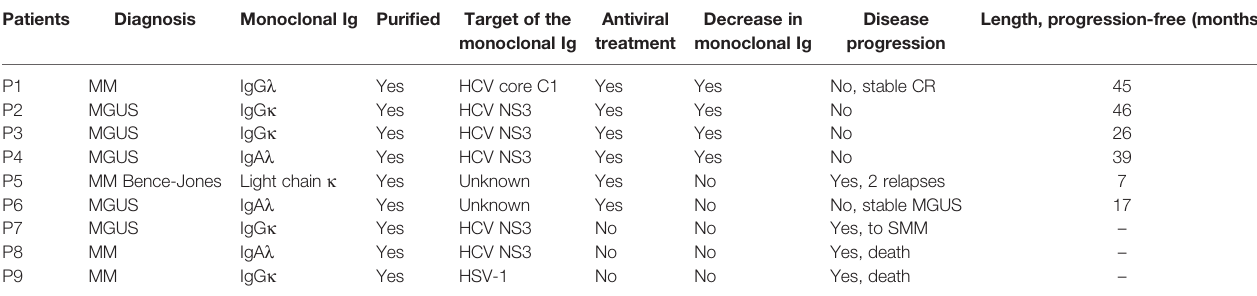
TABLE 2 | Classi fi cation of patients, response to anti-HCV treatment and MGUS or MM evolution. Patients